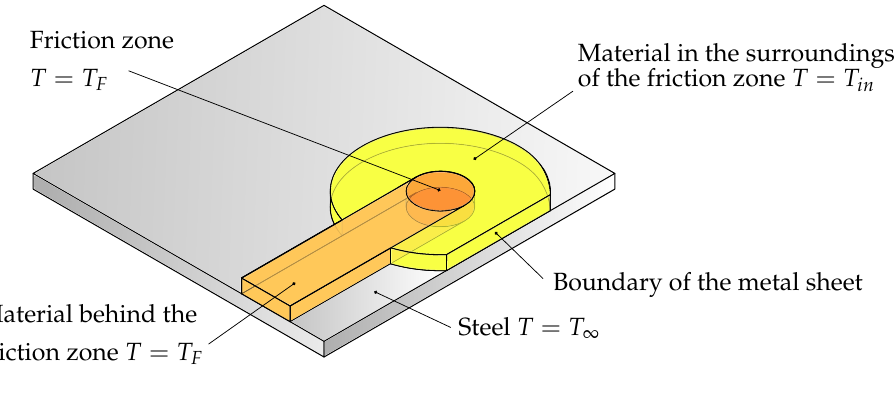
Figure 4. Different thermal areas of the simplified thermal